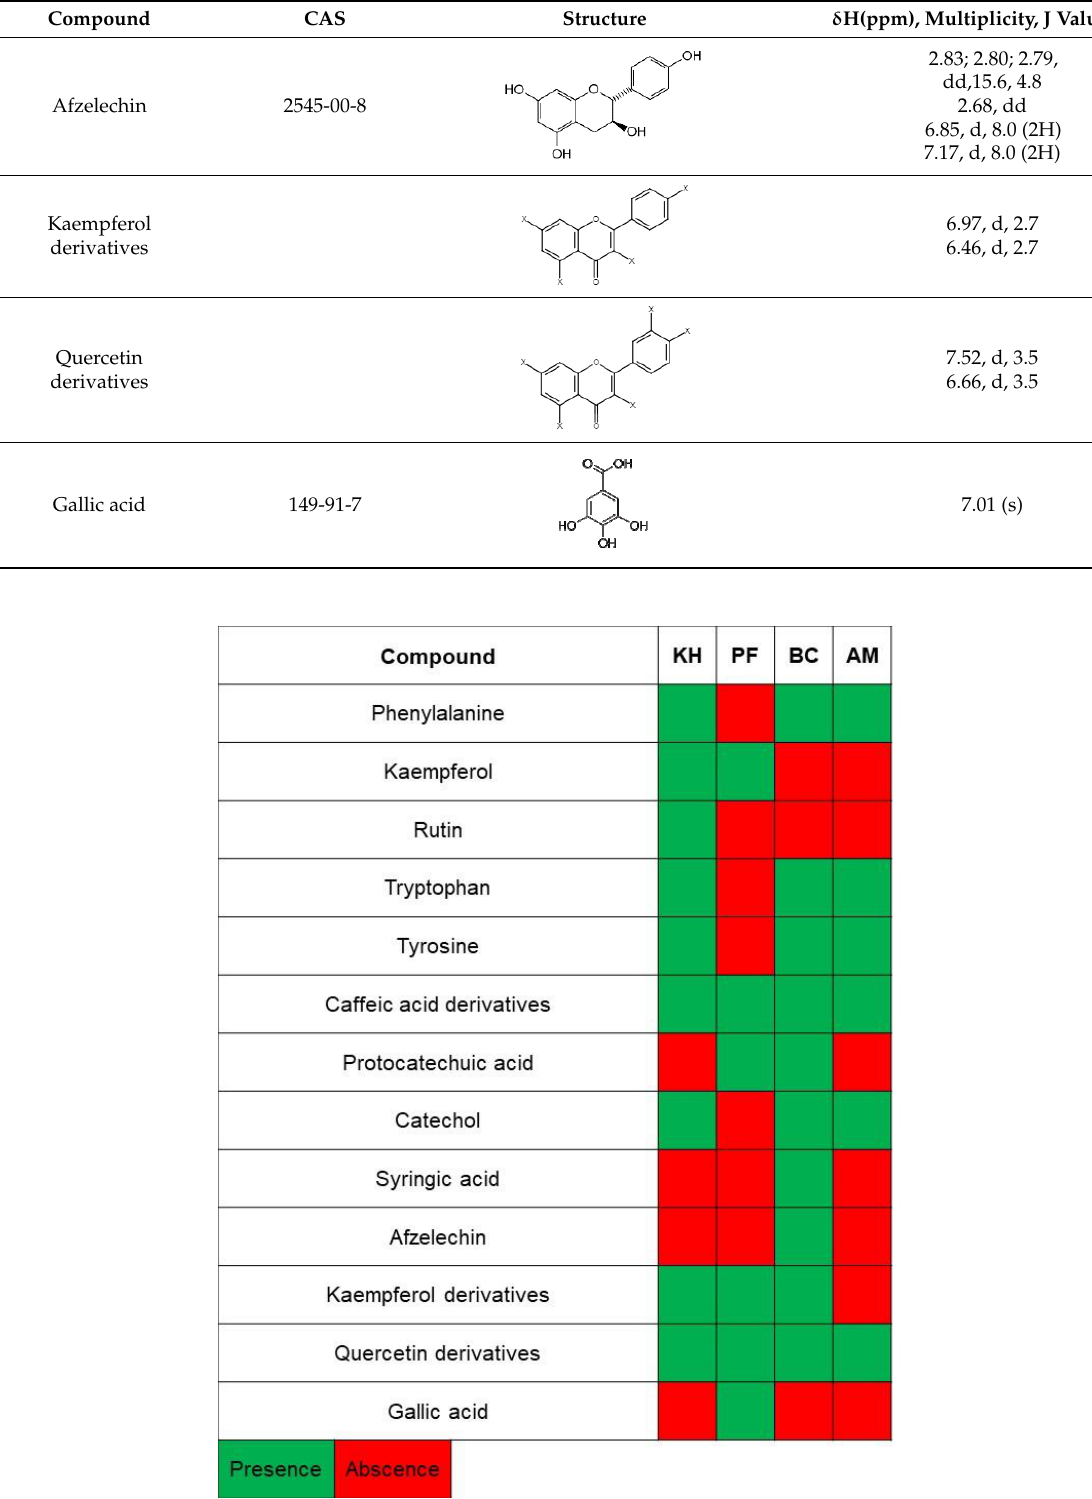
Figure 2. ( A ) The representative 1 H-NMR spectra in the δ 3.00 to 5.00 range of kiwifruits ( a ) Hayward, ( b ) Bidan, ( c ) A. arguta and ( d ) persimmon Fuyu; ( B ) the representative expanded 1 D-NMR spectra in the δ 0.02 to 3.00 range from top to bottom: Hayward, Bidan, A. arguta and persimmon Fuyu.